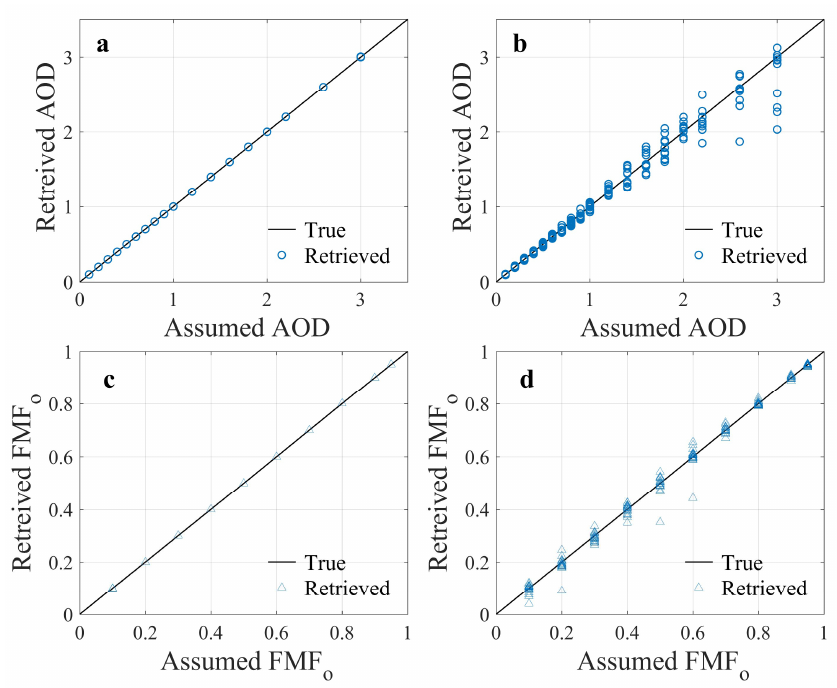
Figure 4. The scatter plot between retrieved results and true values at 550 nm, for eighteen di ff erent aerosol loadings from AOD = 0.1 to 3.0 and ten di ff erent mixed states from FMF o = 0.1 to 0.95. ( a ) and ( c ) in left panel represents retrieval of V 0 and FMF o without observation noise added. ( b ) and ( d ) in right panel represents retrieval of V 0 and FMF o with 5% random noise added.